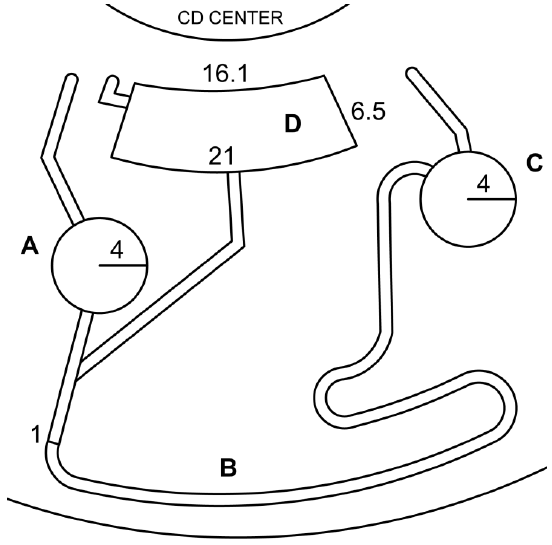
The chambers are 1.4 mm deep and the channels are 700 m deep. The Sample Chamber